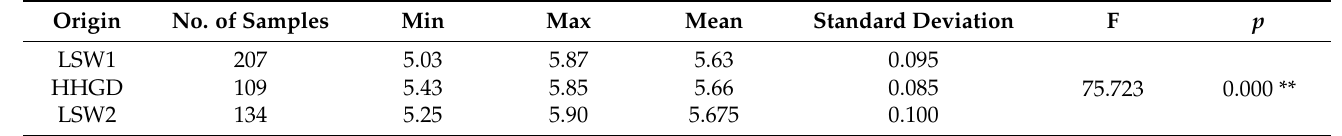
Table 7. Statistical results of the measured fruit acidity (pH) values of all ‘Dangshan’ pear samples.